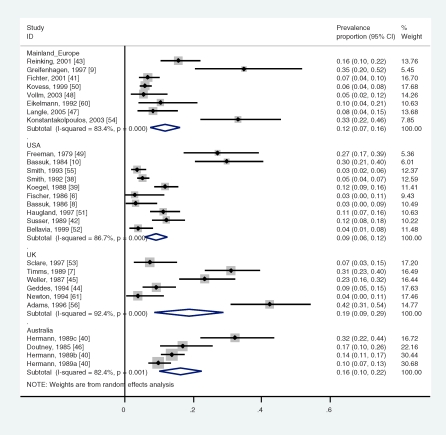
Prevalence of Psychosis in Homeless Persons by Country Group